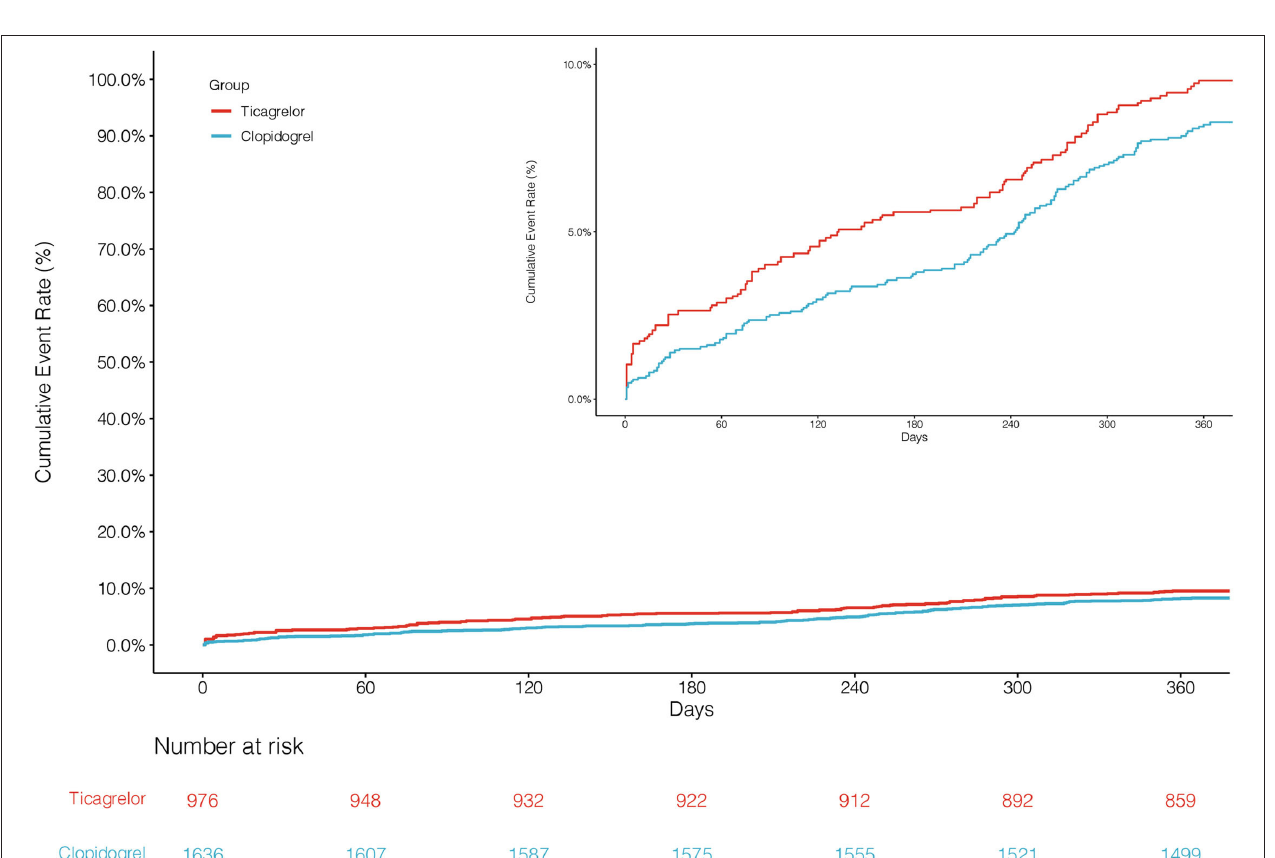
Figure 2 ). The secondary endpoint MACCE occurred in